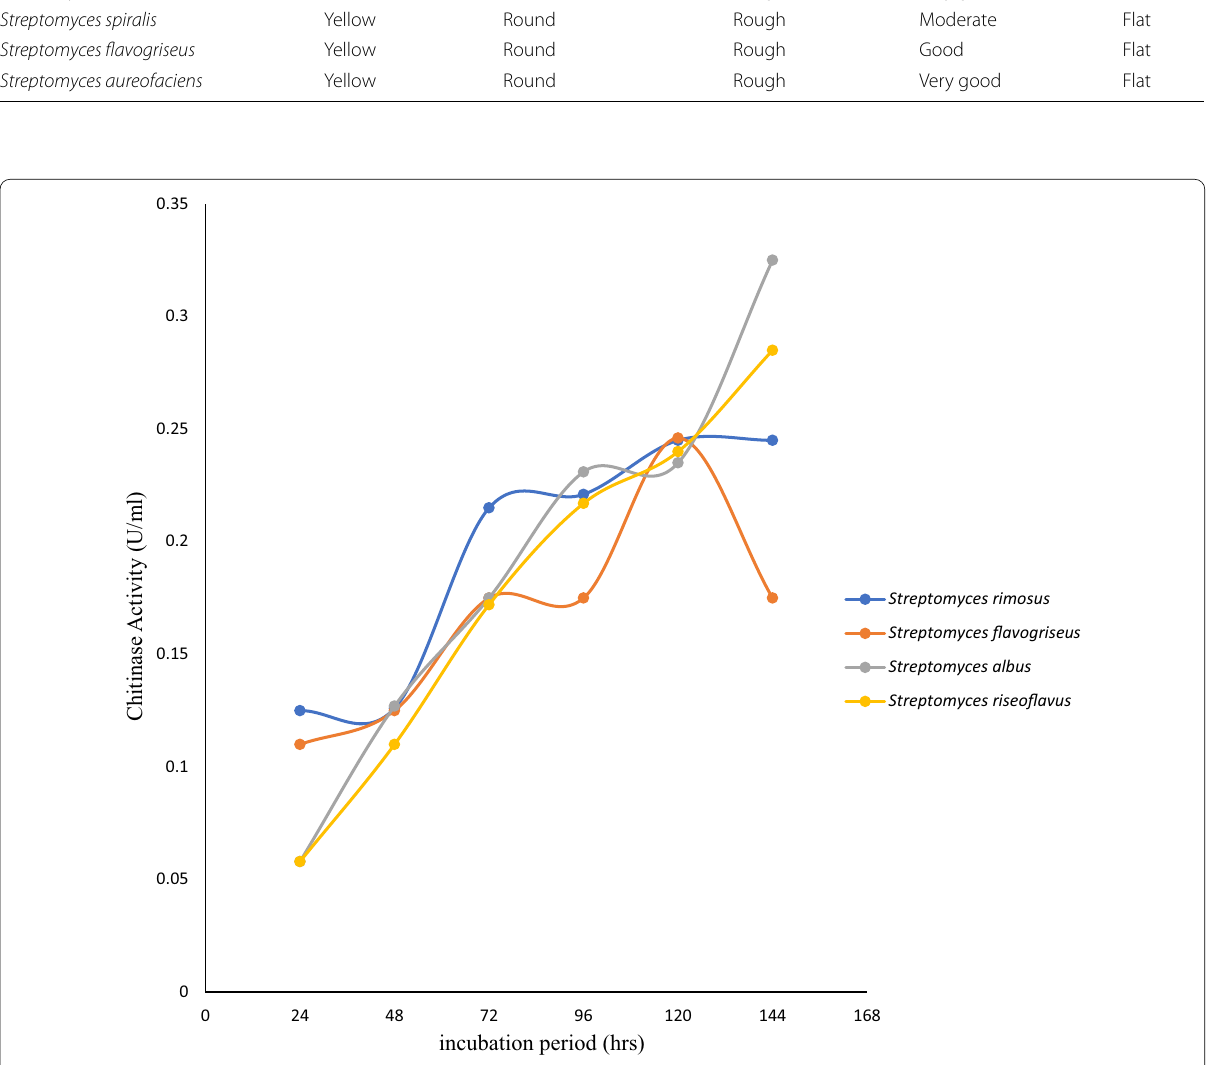
Fig. 1 Growth pattern of the Streptomyces isolates that were able to produce chitinase at different incubation